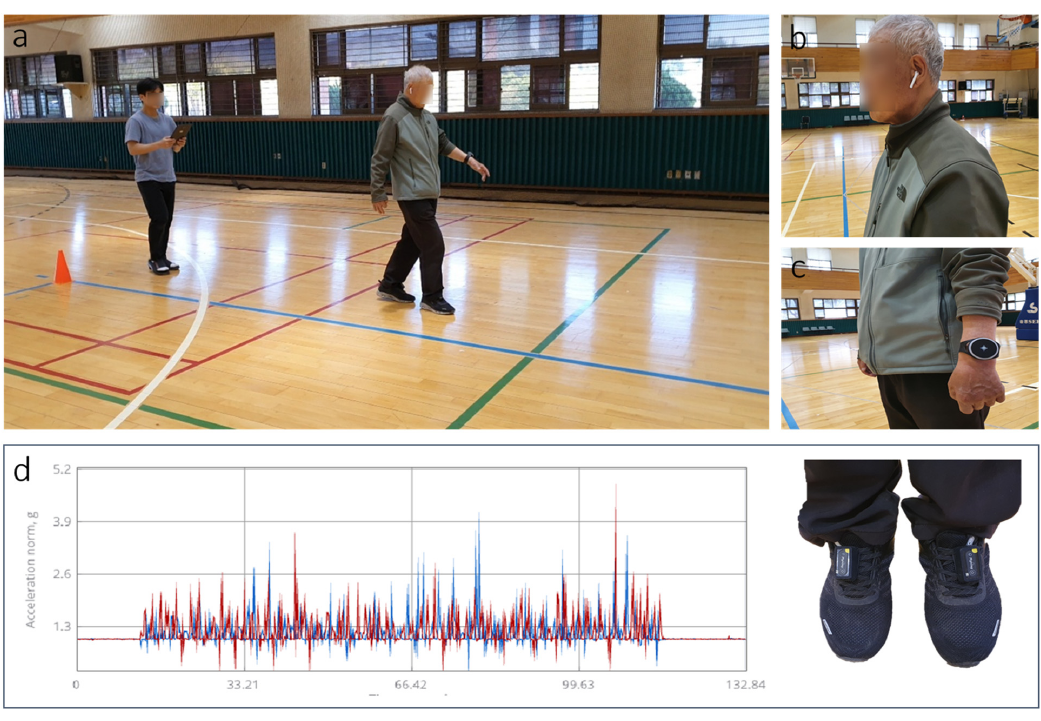
Figure 2. Example of a gait protocol using rhythmic sensory stimulation. ( a ) Experimental scene of a patient with stroke during a 60 m walk; ( b ) rhythmic auditory stimulation (RAS) condition; ( c ) rhythmic somatosensory stimulation (RSS) condition; ( d ) raw data extracted from 7D IMU sensor.